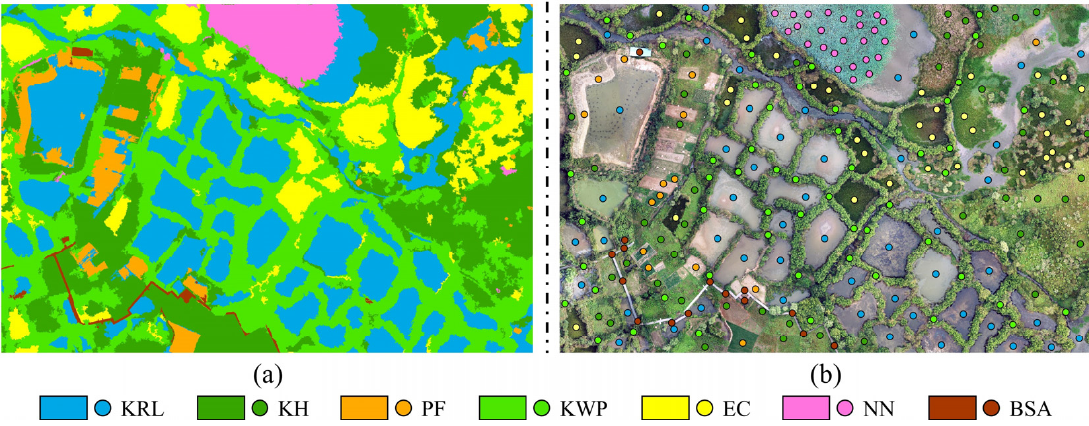
Figure 2. Semantic label and the distribution of quadrat. ( a ) Label, ( b ) DOM and sampling point. Table 2. Number of sample points and pixels for accuracy assessments.